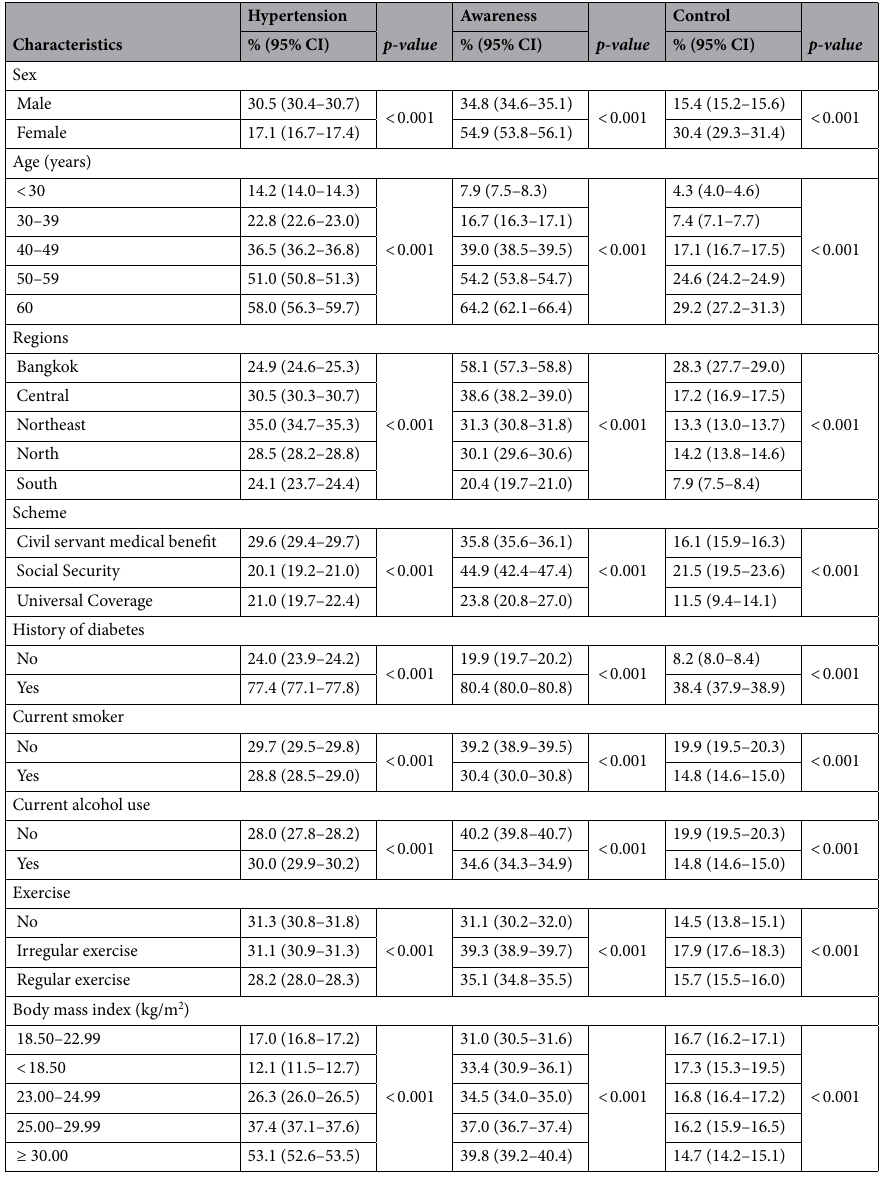
Table 4. Prevalence, awareness and control of hypertension among RTA personnel by characteristics (2017– 2021). CI confidence